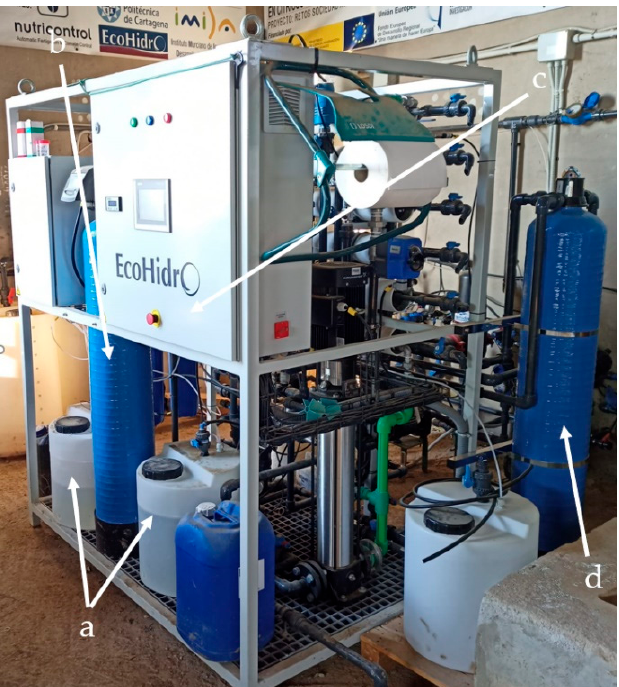
Figure 1. Picture of the experimental on-farm ion exchange resin system: (a) HCl and NaOH tanks; (b) zeolite and pyrolusite bed filter; (c) control panel; (d) ion exchange resin column.